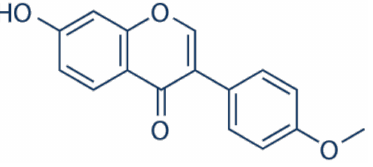
Figure 12. The chemical structure of